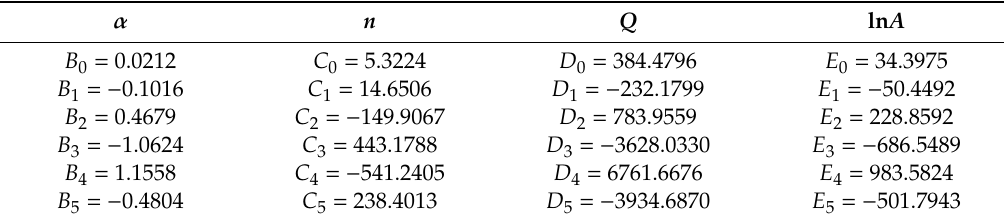
Table 2. Fifth-degree polynomial coe ffi cients of ln A , α , Q , and n .